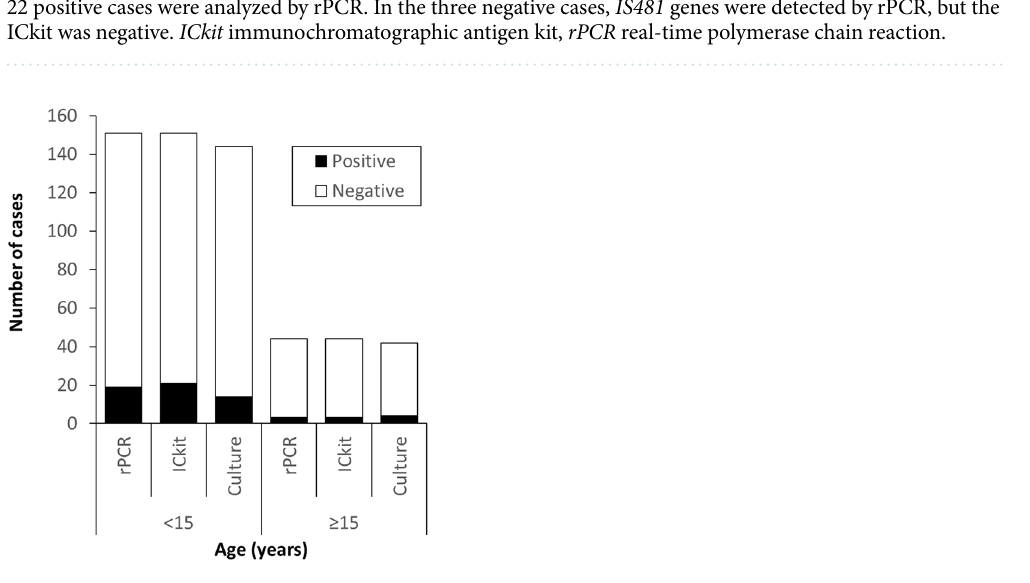
Figure 3. The results of rPCR, the ICkit, and culture by age group. A total of 195 cases were analyzed. Nine cases were tested by the ICkit and rPCR, but not tested by culture. ICkit immunochromatographic antigen kit, rPCR real-time polymerase chain